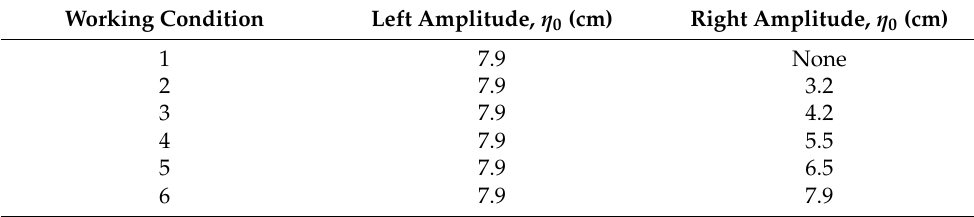
Table 2. Internal solitary wave